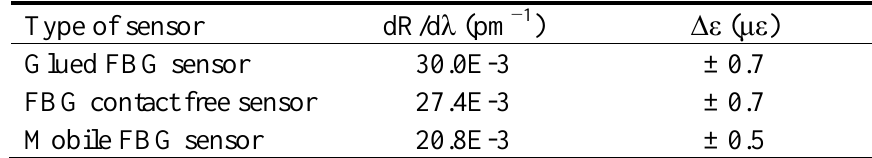
Table 2. The gradient of the FBG reflection spectrum and evaluated strain change induced by